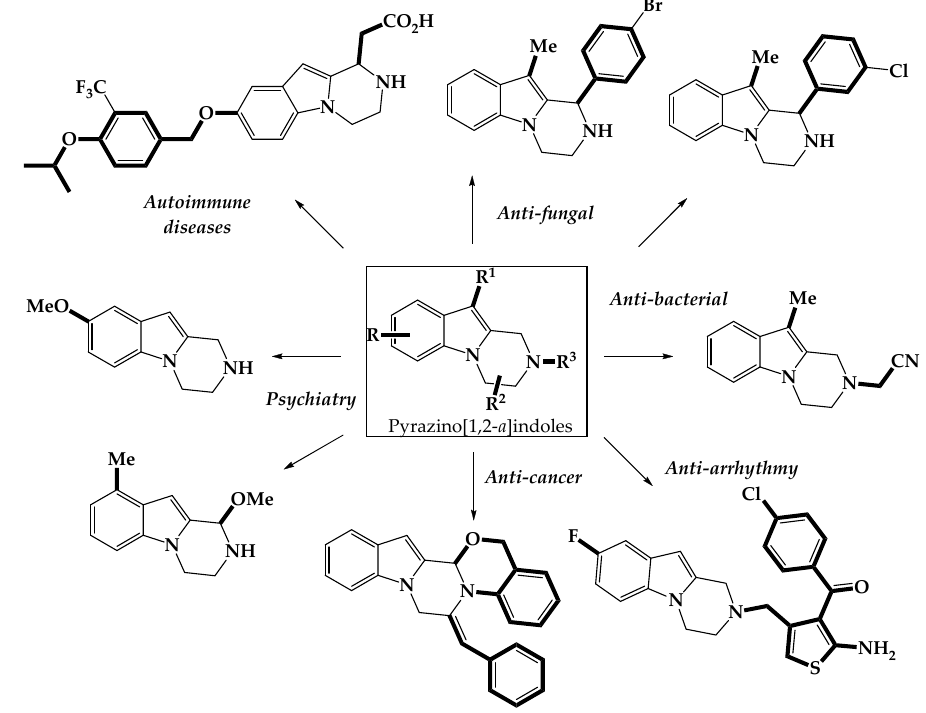
Figure 3. Overview of tetrahydro-pyrazino[1,2- a ]indoles having biological properties.